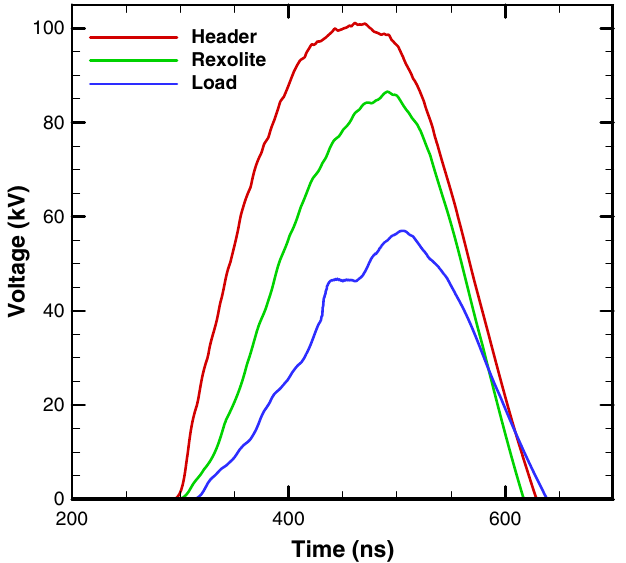
FIG. 7. 3D COMSOL computational setup for calculation of CPF magnetic and electric